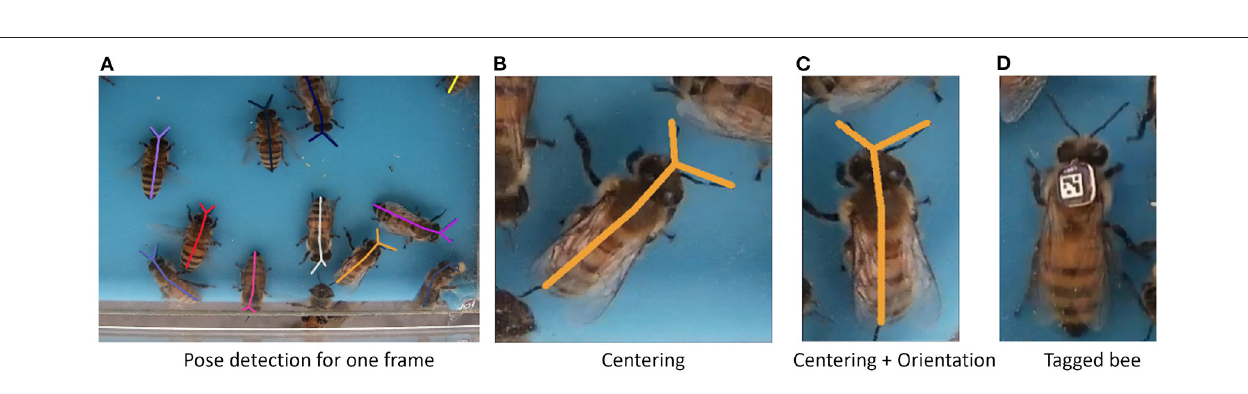
FIGURE 6 | Detail of individual bees. (A) Typical frame with a detected pose. (B) Cropped image with thorax centering. (C) Cropped image with thorax centering and orientation compensation using the head and abdomen axis. (D) Example of bee tagged with a 5 × 5 apriltag barcode of the tag25h5